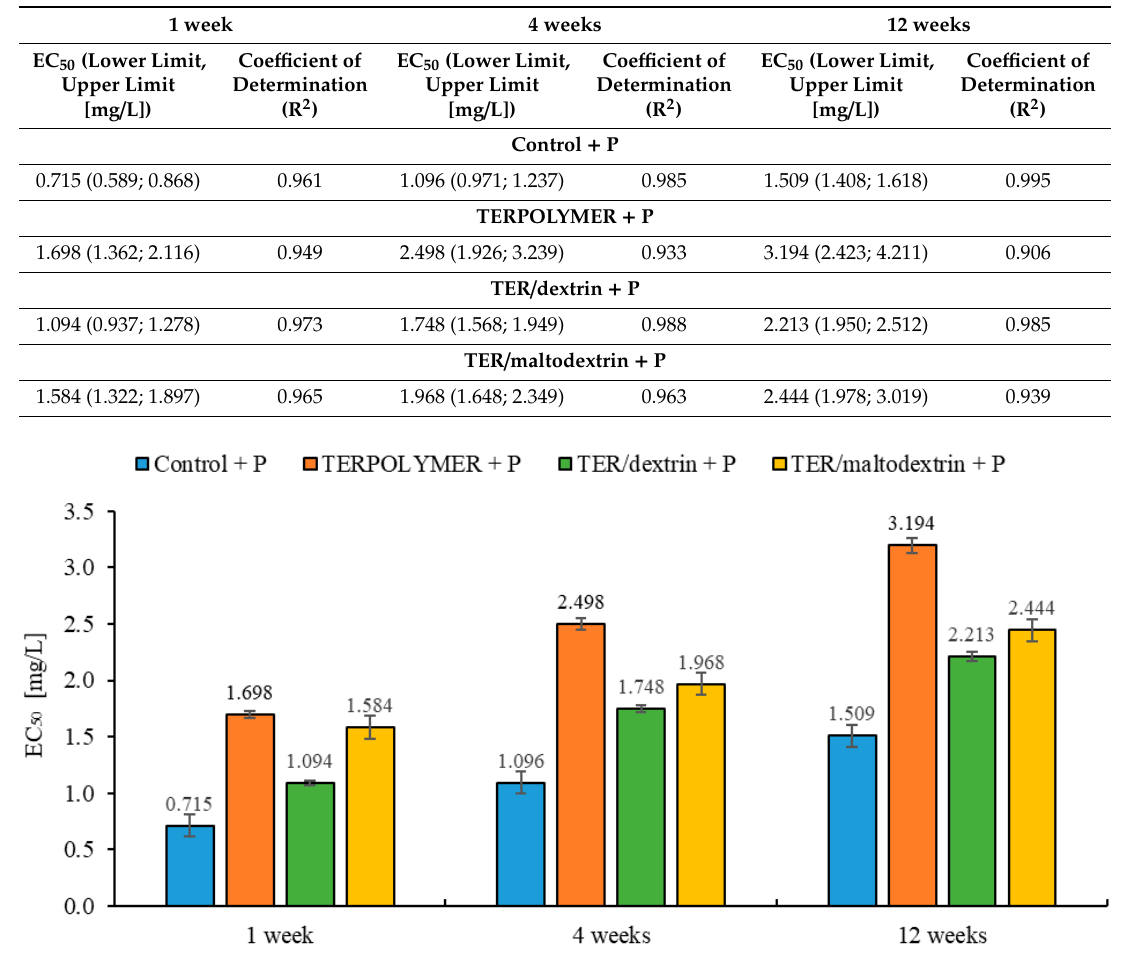
Figure 13. EC 50 values of tested soil with microspheres (TERPOLYMER, TER/dextrin, TER/maltodextrin) loaded with pendimethalin measured during exposure to the A. fischeri .